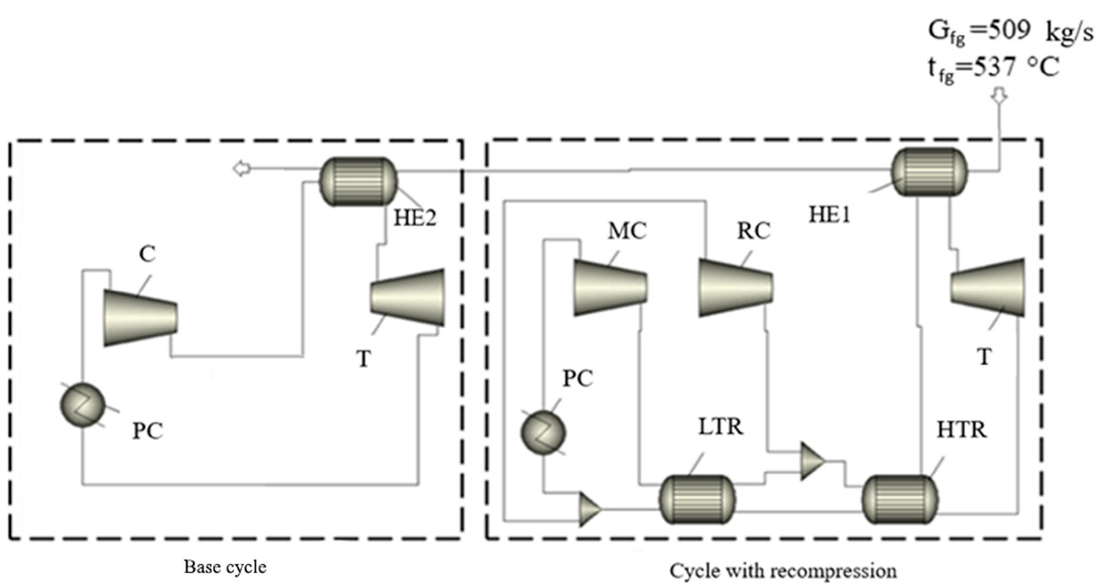
Figure 3. Combined Recompression and base set S-CO 2 Brayton cycle in Aspen Plus.